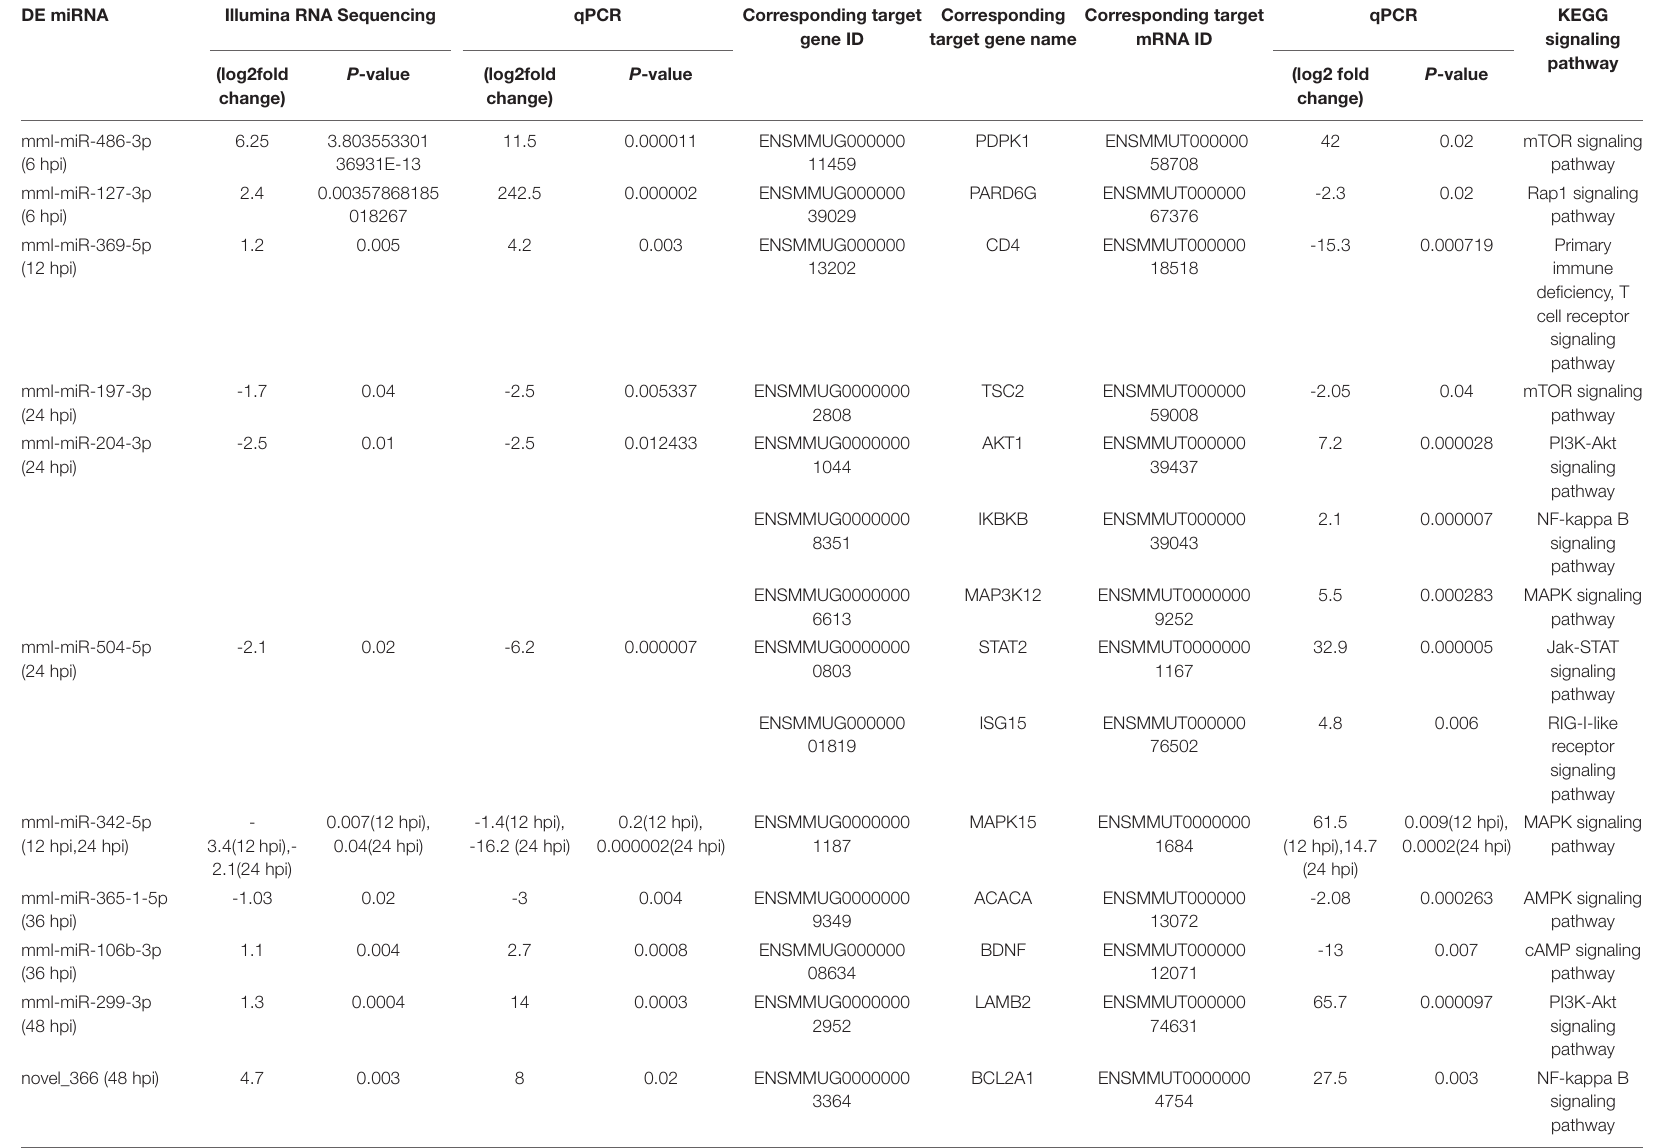
TABLE 1a | The selected DE miRNAs and their corresponding genes, corresponding target mRNA transcripts and the signaling pathways they implicated in. DE